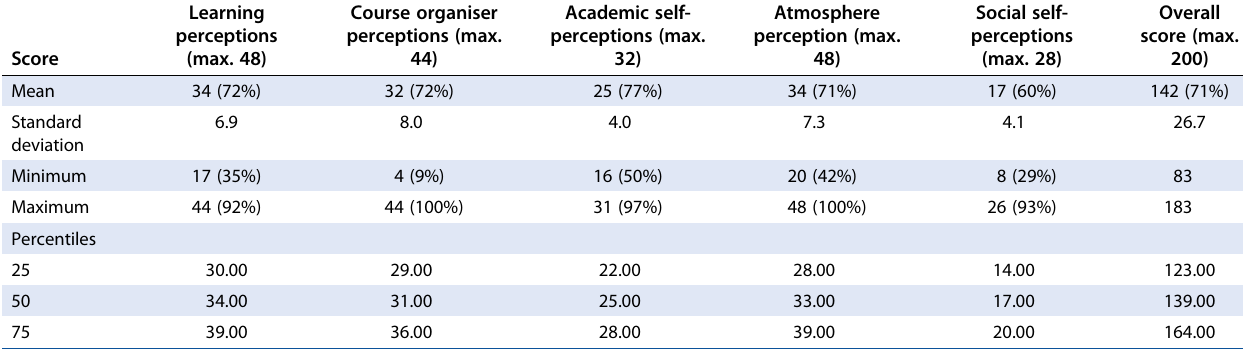
Table 2: Scores for the five subscales of the DREEM questionnaire